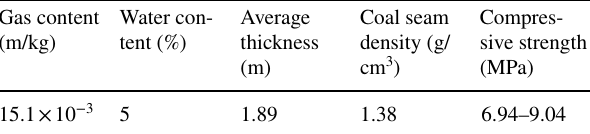
Table 1 Basic parameters of coal seam